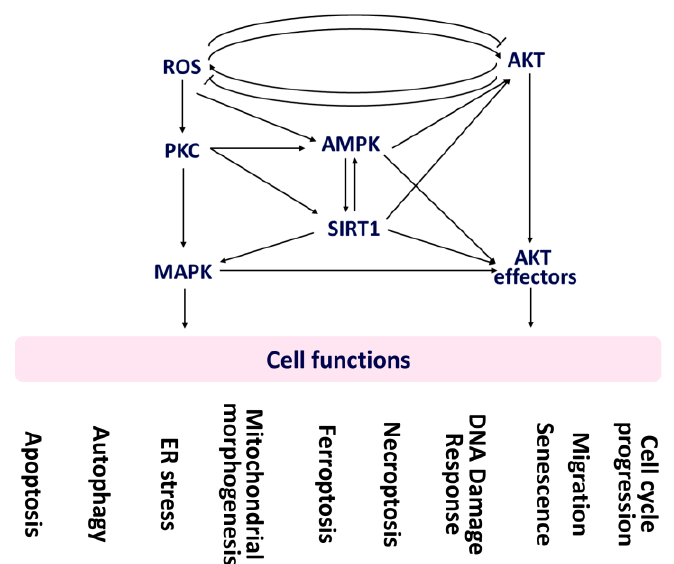
Figure 1. Network for oxidative stress and AKT pathway regulations of cell functions in cancer cell treatments. Several AKT effectors are included in this review, such as forkhead box transcription factors (FOXO), c-Myc, hypoxia-inducible factor (HIF), mechanistic target of rapamycin complex 1/2 (mTORC1/2), mTOR substrate S6 kinase 1/2 (S6K1/2), sterol regulatory element-binding protein 1 (SREBP1), and glycogen synthase kinase 3 (GSK3). Several cell functions are included, such as apop- tosis, autophagy, ER stress, mitochondrial morphogenesis, ferroptosis, necroptosis, DNA damage response, senescence, migration, and cell-cycle progression.